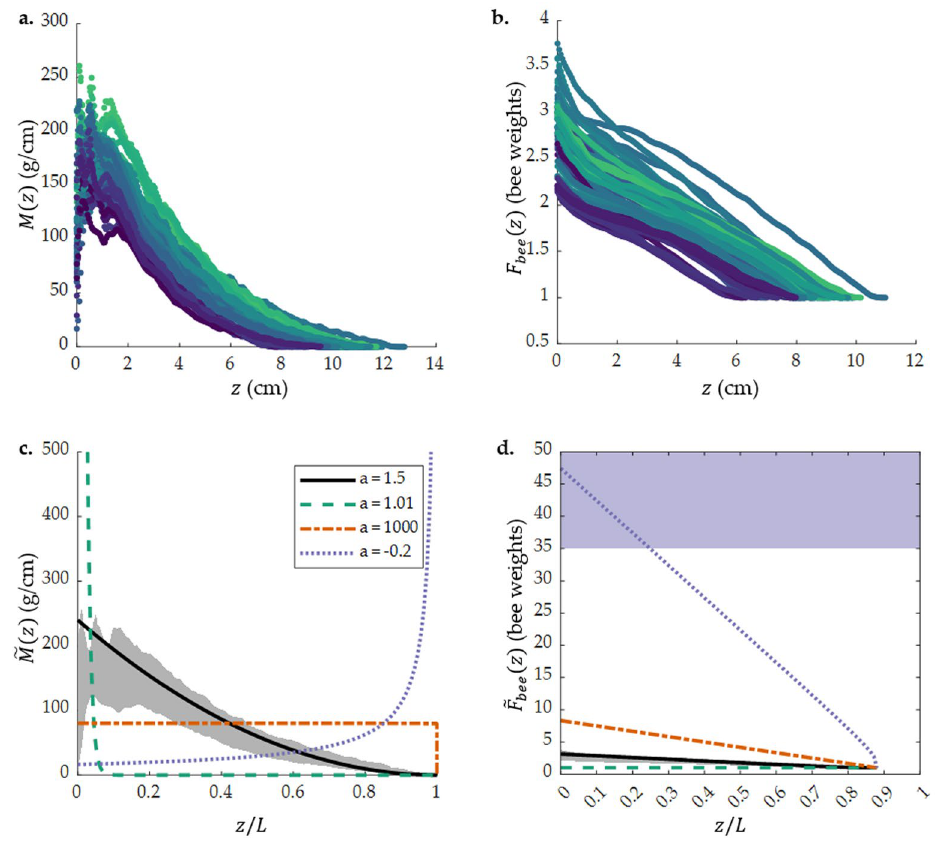
Figure 3. ( a ) Mass of swarm layers, M ( z ), plotted for all 57 reconstructions. M ( z ) peaks and then decreases with the z coordinate. ( b ) Mean force supported by a bee in a layer, F bee ( z ) , vs z . The maximum force per bee is 3.8 bee weights, and the force decreases along the z axis. The lowest possible F bee ( z ) is one bee weight—a bee only supporting its own weight. ( c ) Theoretical mass distribution between the layers of a 1000-g, 12.5-cm long swarm with varying exponent a , with normalized z-coordinate z / L on the x-axis and mass per layer ˜ M ( z ) on the y-axis. The shaded gray region is the range of values for the experimental data in ( a ). ( d ) Theoretical mean force per bee for a 1000-g, 12.5-cm long swarm with varying exponent a , with z / L on the x-axis and force per bee ˜ F bee ( z ) on the y-axis. The shaded gray region is the range of values for the experimental data in ( b ); the shaded purple region for ˜ F bee ( z ) > 35 bee weights represents the maximum number of bees that a single bee can support. In ( c ) and ( d ), the solid black line corresponds to a = 1.5 : the experimentally measured mass distribution, with more massive layers near the attachment surface ( z / L = 0 ). Dashed green line corresponds to a = 1.01 : a swarm with most of its mass concentrated in the top layer of the swarm, and very few bees found beneath that layer. Dash-dot orange line corresponds to a = 1000 : a swarm in which all of the layers have equal mass. Dotted purple line corresponds to a = − 0.2 : a swarm in which the layers near the attachment surface have a lower mass than the layers at the bottom of the